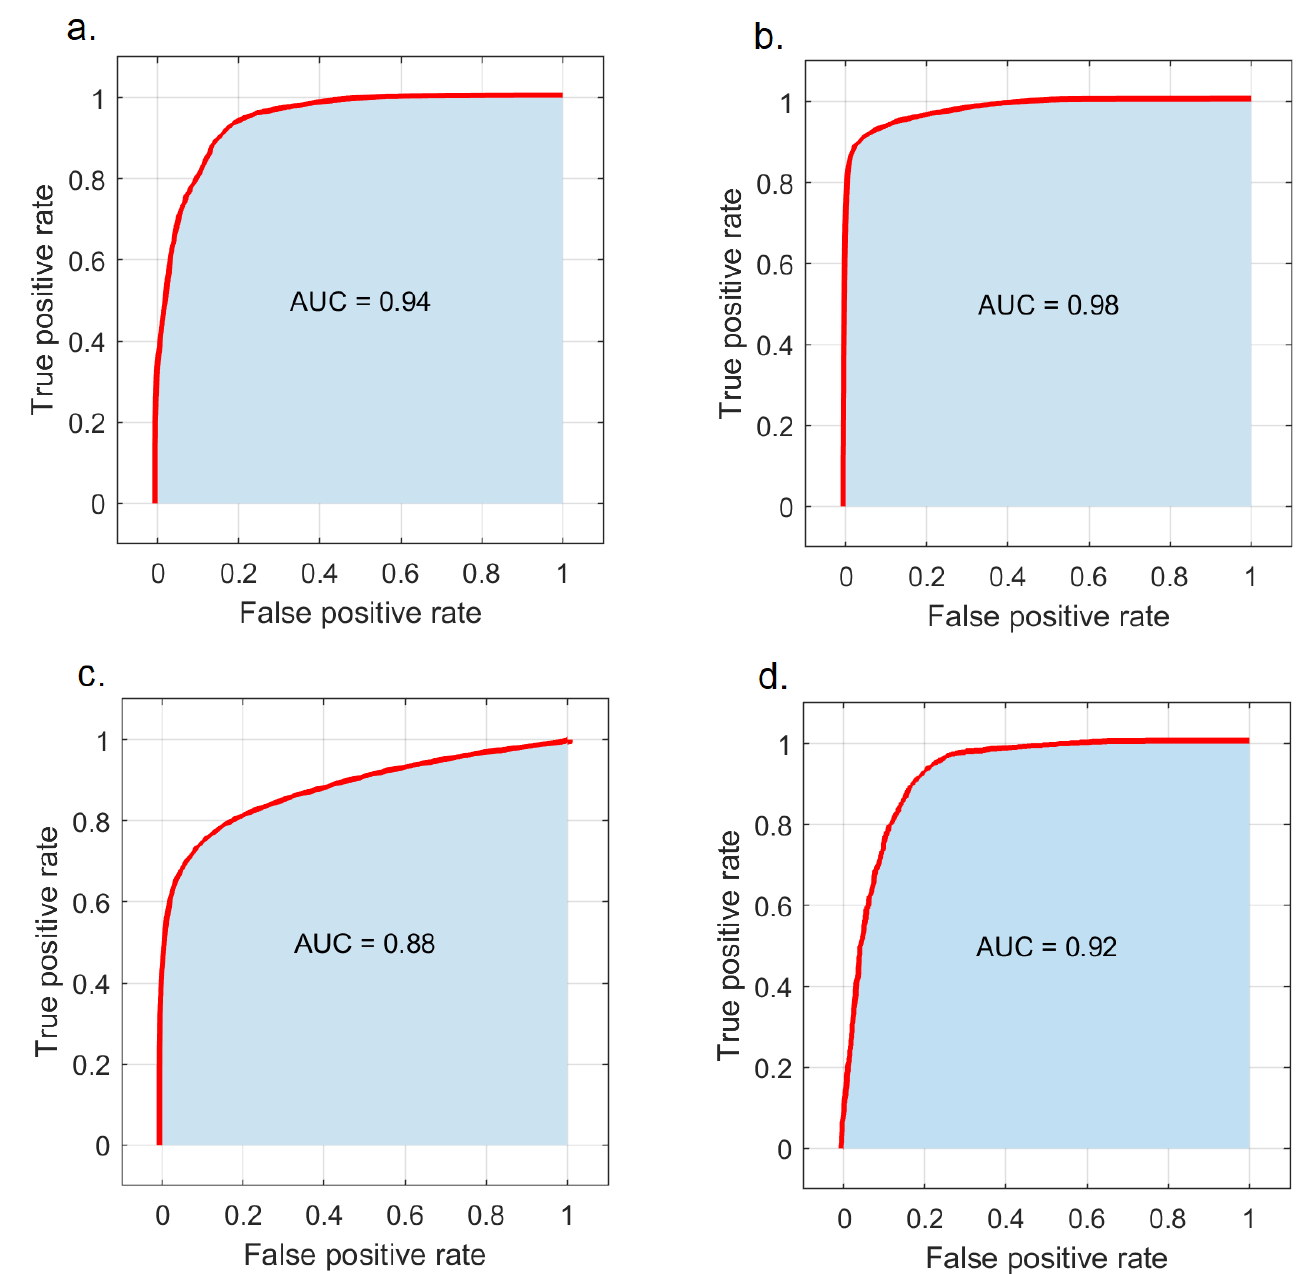
Figure 3. Patient classification performance of the SVM classifier. ( a ) ROC curve obtained from PTG and OSSN classification. ( b ) ROC curve obtained from normalized normal and OSSN classification. ( c ) ROC curve obtained from normal and PTG classification. ( d ) ROC curve obtained from normal, PTG, and OSSN classification.